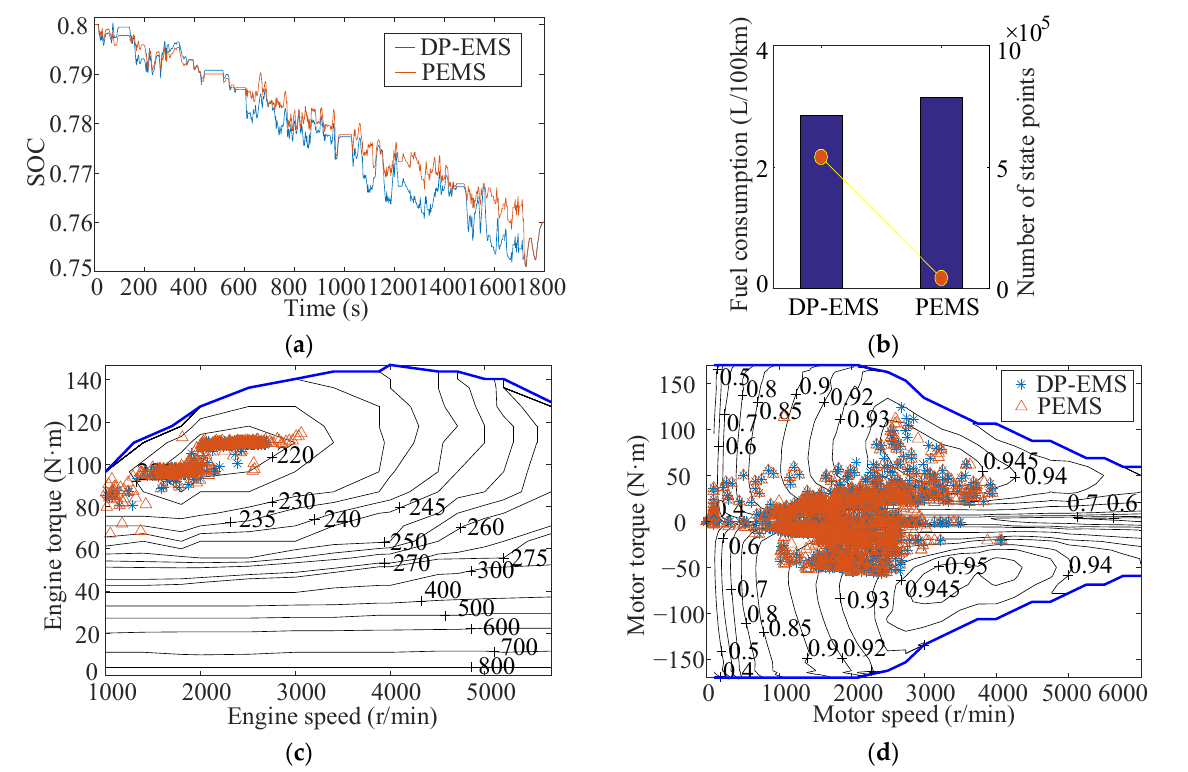
Figure 21. The simulation result of 10 s time scale under WLTC cycle. ( a ) Battery SOC; ( b ) Fuel consumption; ( c ) Engine; ( d ) Motor.